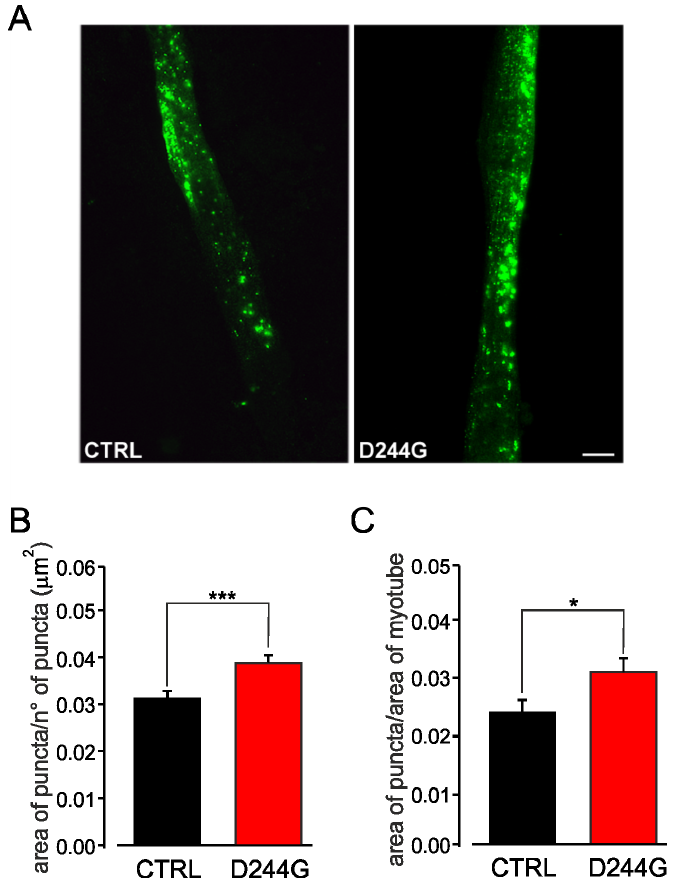
Fig 1. Sarcoplasmic inclusions of CASQ1 in myotubes. ( A ) Immunocytochemical staining of CASQ1-positive puncta in control ( left panel ) and patient ( right panel ) myotubes (scale bar = 10 μ m). ( B ) Averaged area of CASQ1-positive puncta in control and patient myotubes expressed as: total area of puncta ( μ m 2 )/n°of puncta. ( C ) Average ratio of CASQ1-positive puncta in control and patient myotubes expressed as total area of puncta ( μ m 2 )/total area of myotube ( μ m 2 ). The data are mean ± SEM ( * p < 0.05, *** p <